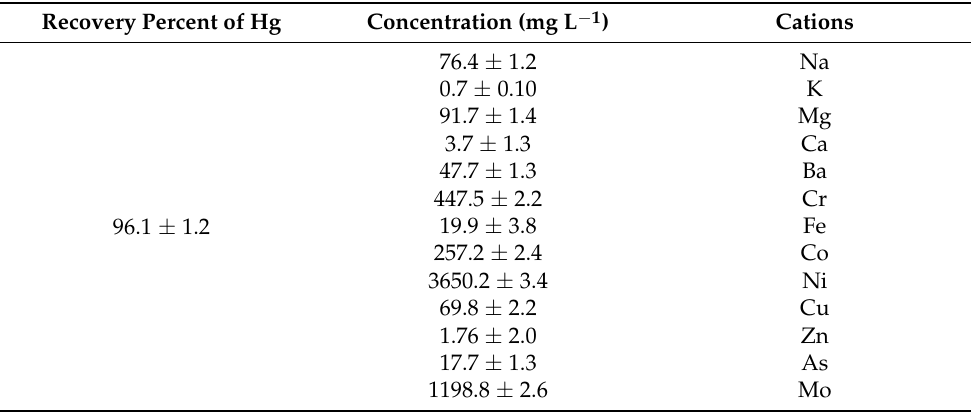
Table 5. Recovery of Hg in the presence of metal